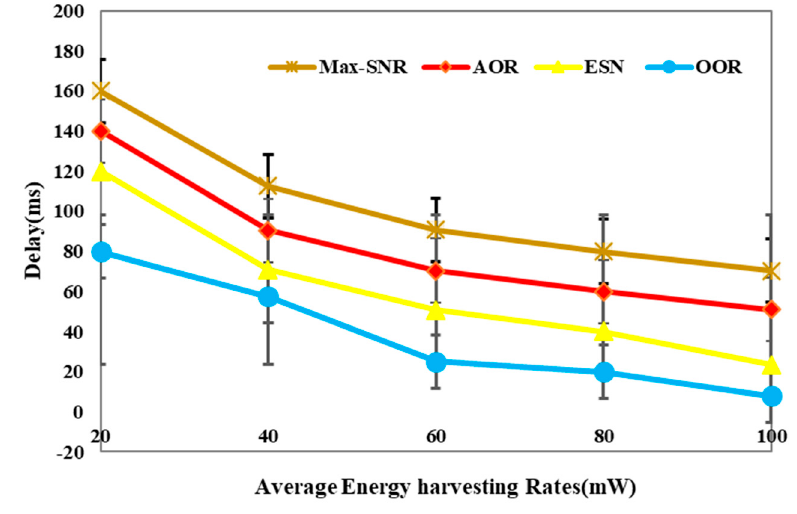
Figure 10. Delay comparison with varying average energy harvesting rates.